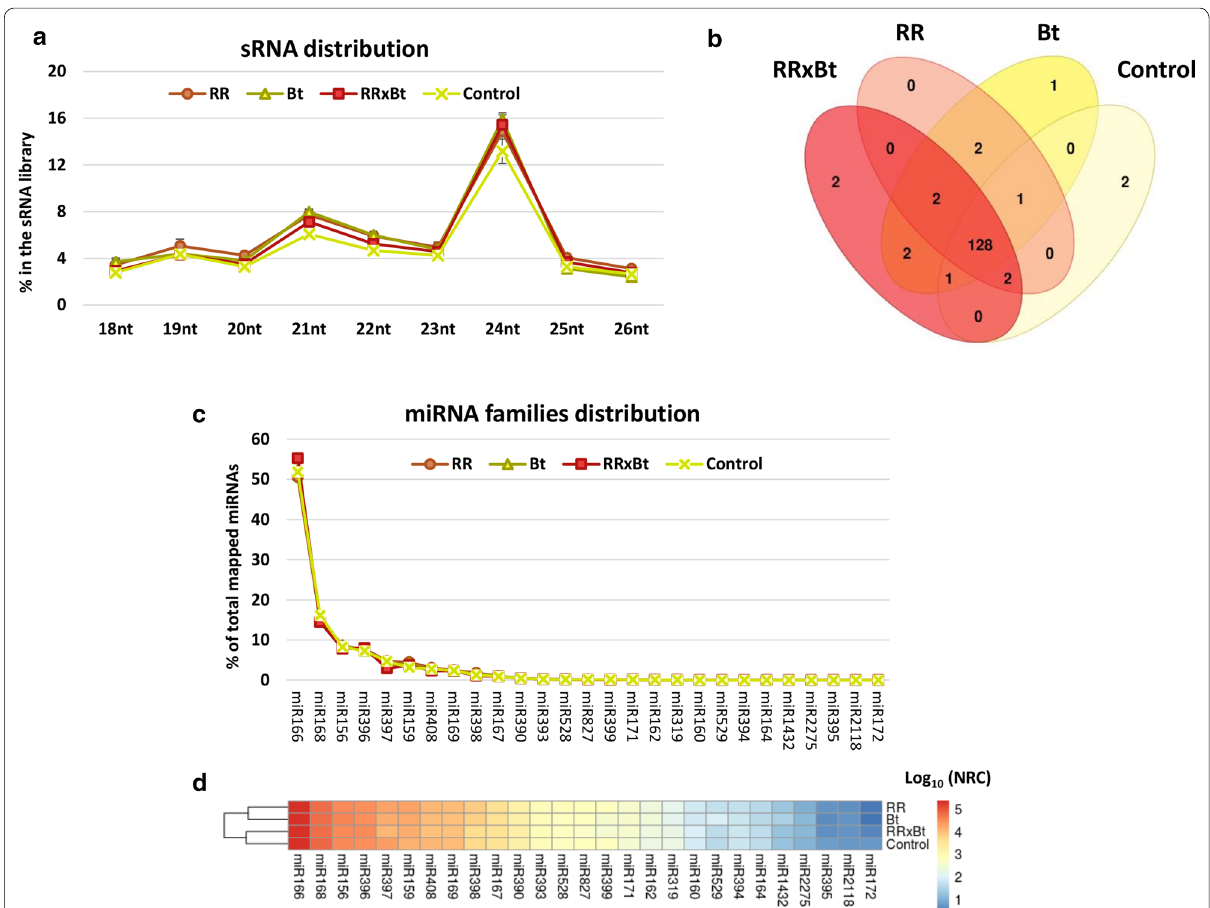
Fig. 2 Alignment of sRNA reads with the Zea mays reference genome. a Size distribution (18–26 nt) of sRNA reads for each of the varieties analysed; b venn diagram showing the number of conserved miRNAs identified in each variety; c distribution of the identified conserved miRNAs along maize miRNA families for each of the analysed varieties; d heatmap of the normalized read count (NRC) for each of the conserved miRNA families in the analysed varieties. The NRC values were log10 transformed for better visualization